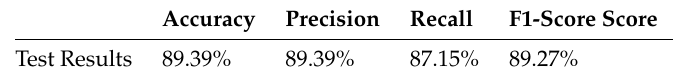
Table 20. Evaluation results of the model trained by CNN network using measurements with